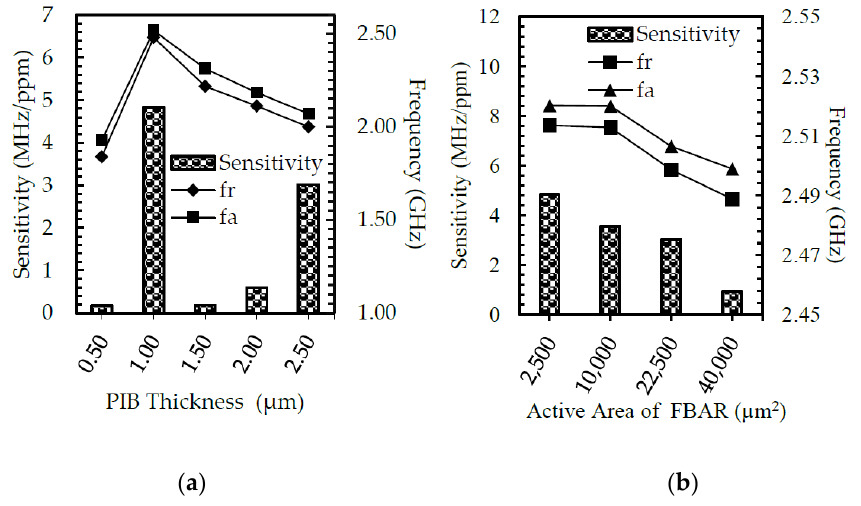
Figure 7. ( a ) Thickness optimization and ( b ) area optimization of fractal electrode-based FBAR in order to obtain high sensitivity.